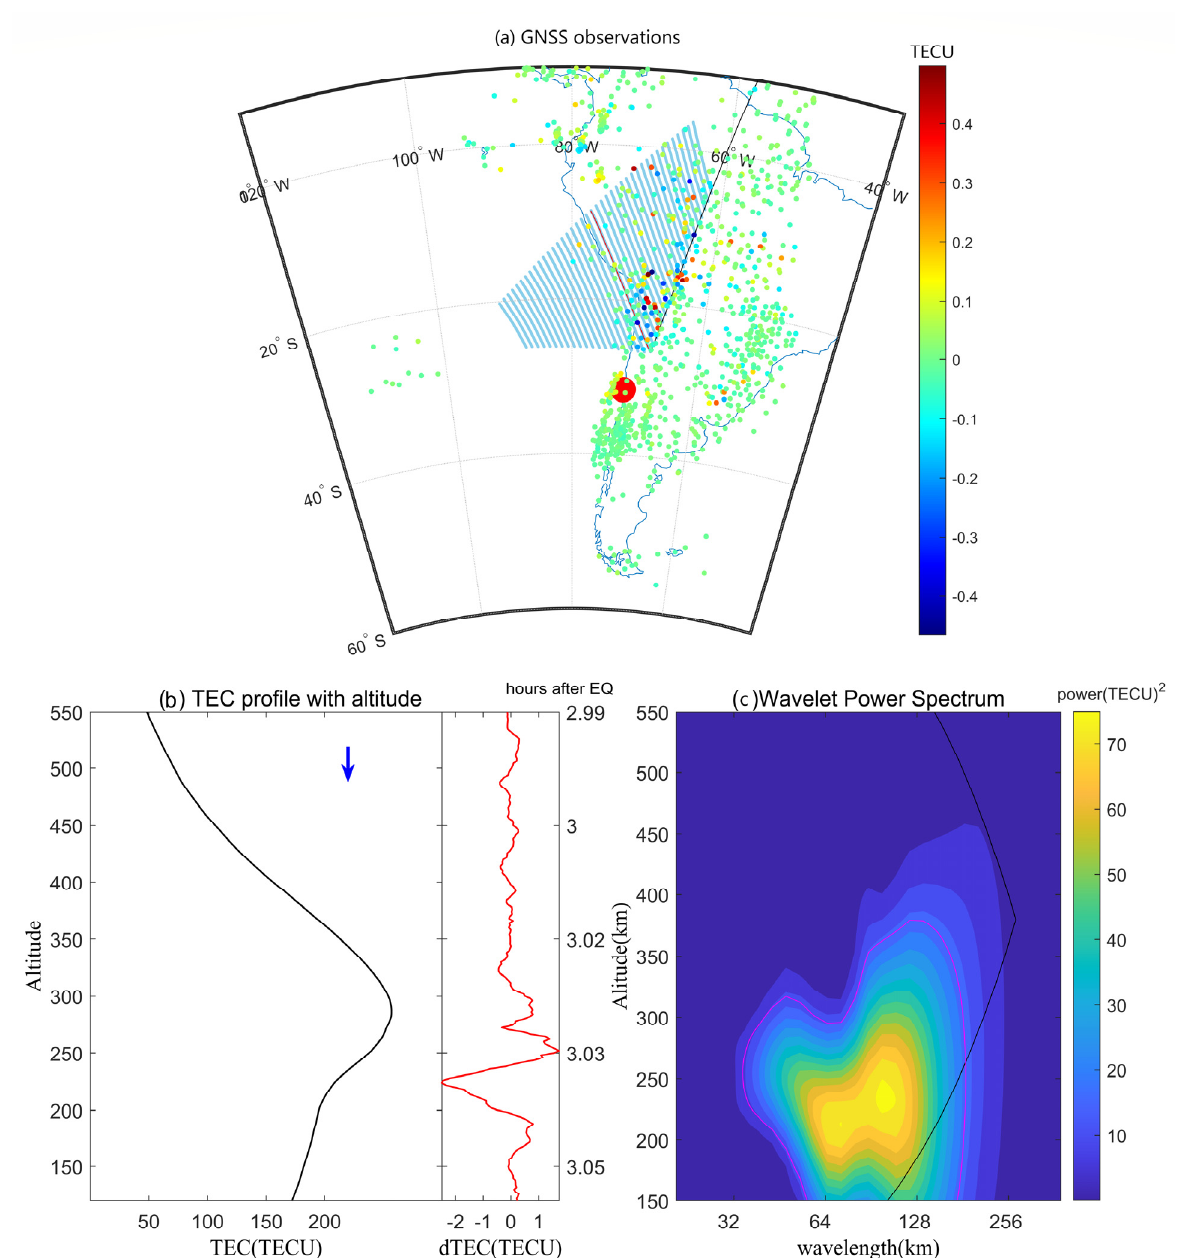
Figure 7. ( a ) Ground-based GNSS dTEC map at 01:54 UT, 17 − 09 − 2015. The TEC data is provided by SIMuRG (https://simurg.iszf.irk.ru/ (accessed on 22 October 2022)) [49]. The pale blue area marks the contributing observation area of an RO podTec profile, which is used to track the wavefront after the 2015-09-16 earthquake/tsunami. Red curves represent the projections of the tangent points for the podTec profile. ( b ) The TEC profile in ( a ) with height probed by the F3/C. The blue arrow indicates a descending or ascending scan. The red curve shows the detrended TEC using a Savitzky–Golay filter. The Y-axis scale on the right panel indicates the hours after the tsunami. ( c ) The corresponding WPS. The magenta contour is at the 95% confidence level. The regions outside the black curve are the “cone of influence”, where edge effects become important.